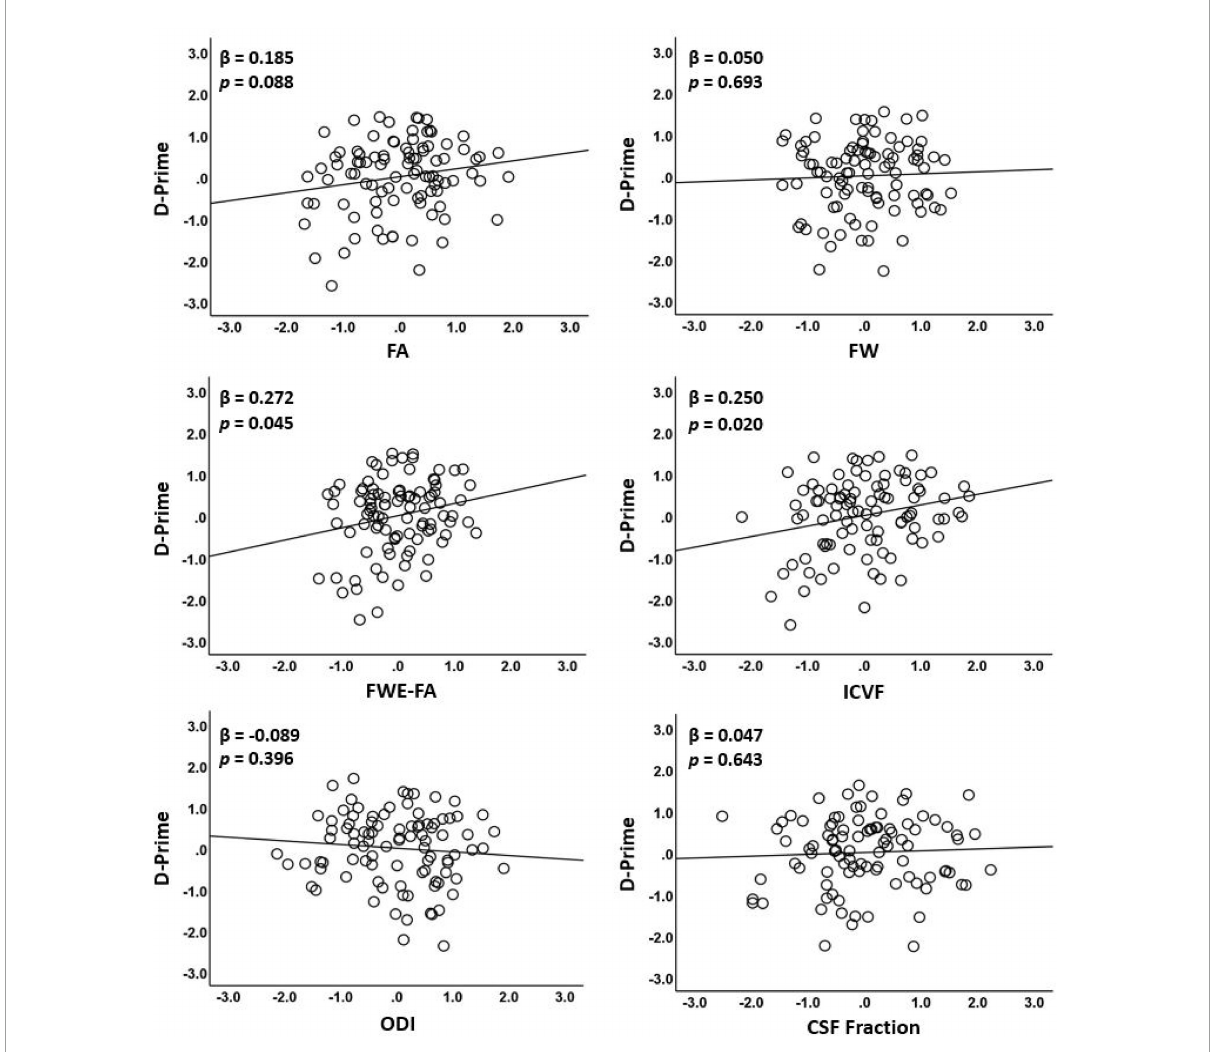
FIGURE3 Associations between diffusion metrics extracted from the WMN-WM mask and working memory performance. The figure displays scatterplots of each diffusion metric against log D-prime during the N-back tasks. Only ICVF and FWE-FA were significantly associated with log D-prime (middle